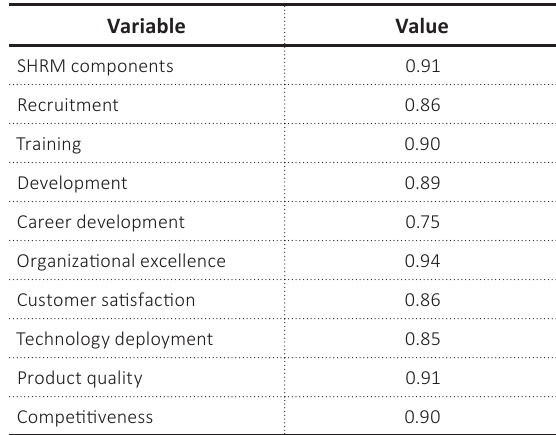
Table 1. Reliability analysis of major variables